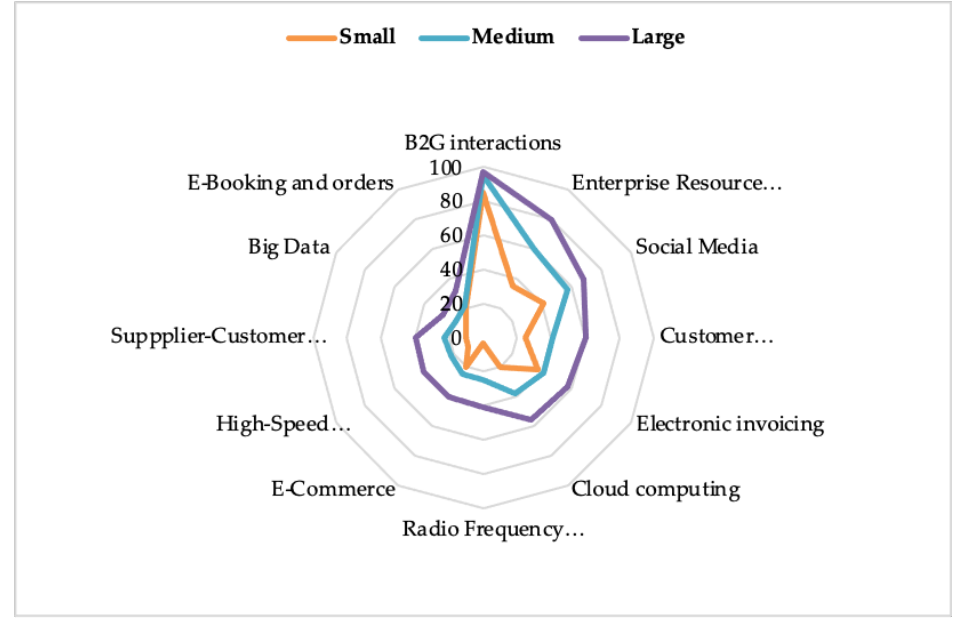
Figure 4. SME gaps in adoption are large in many areas. Source: Authors’ compilation according to [73].